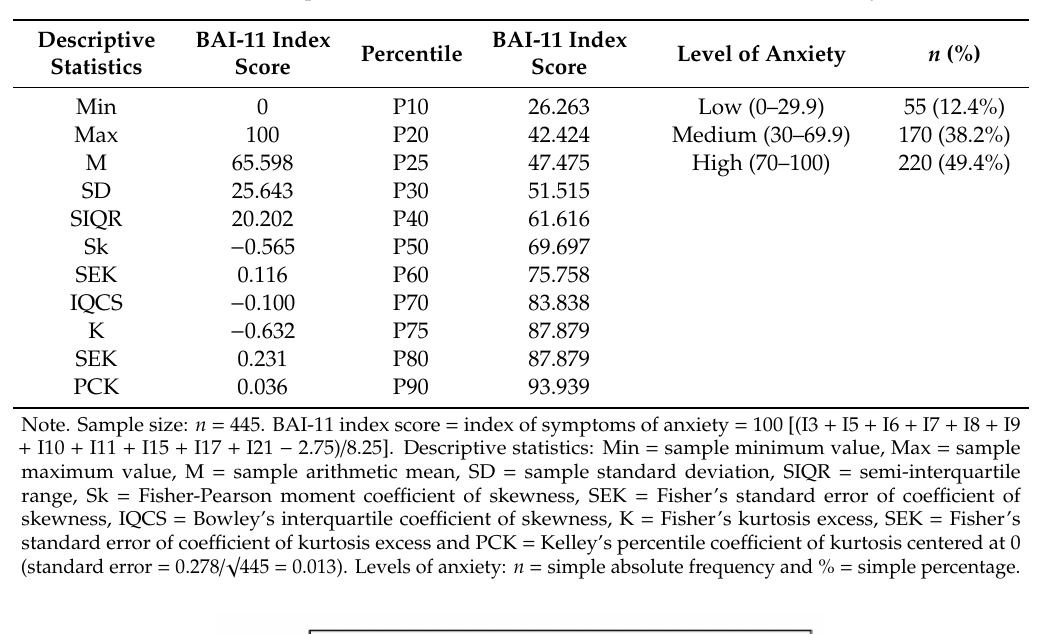
Table 6. Descriptive statistics of BAI-11 index scores and levels of anxiety.